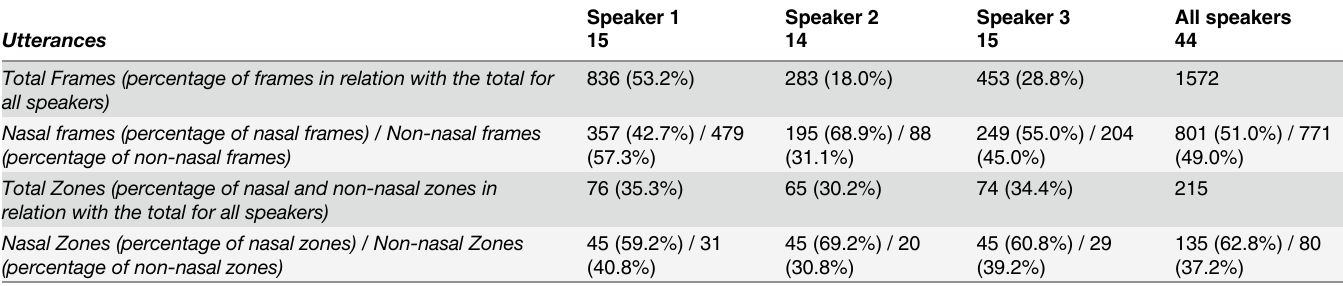
Table 1. Class distribution for all speakers for a single EMG channel by zones and frames (nasal and non-nasal).